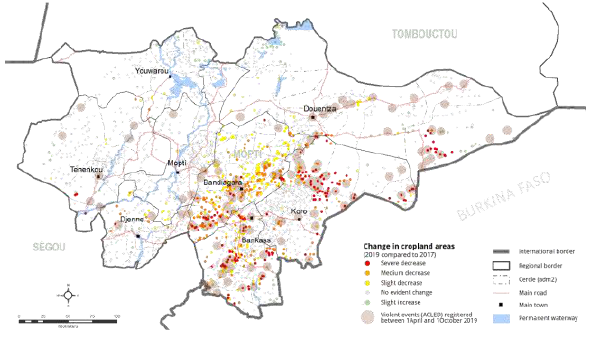
Figure 3 . Cropland change and violent events in 2019 in